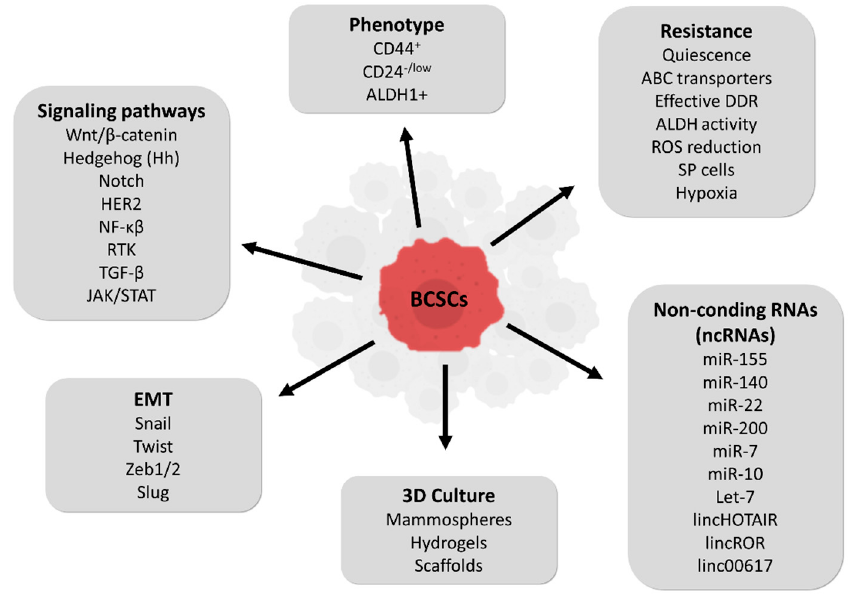
Figure 2. Summary of breast cancer stem cells (BCSCs) characteristics.